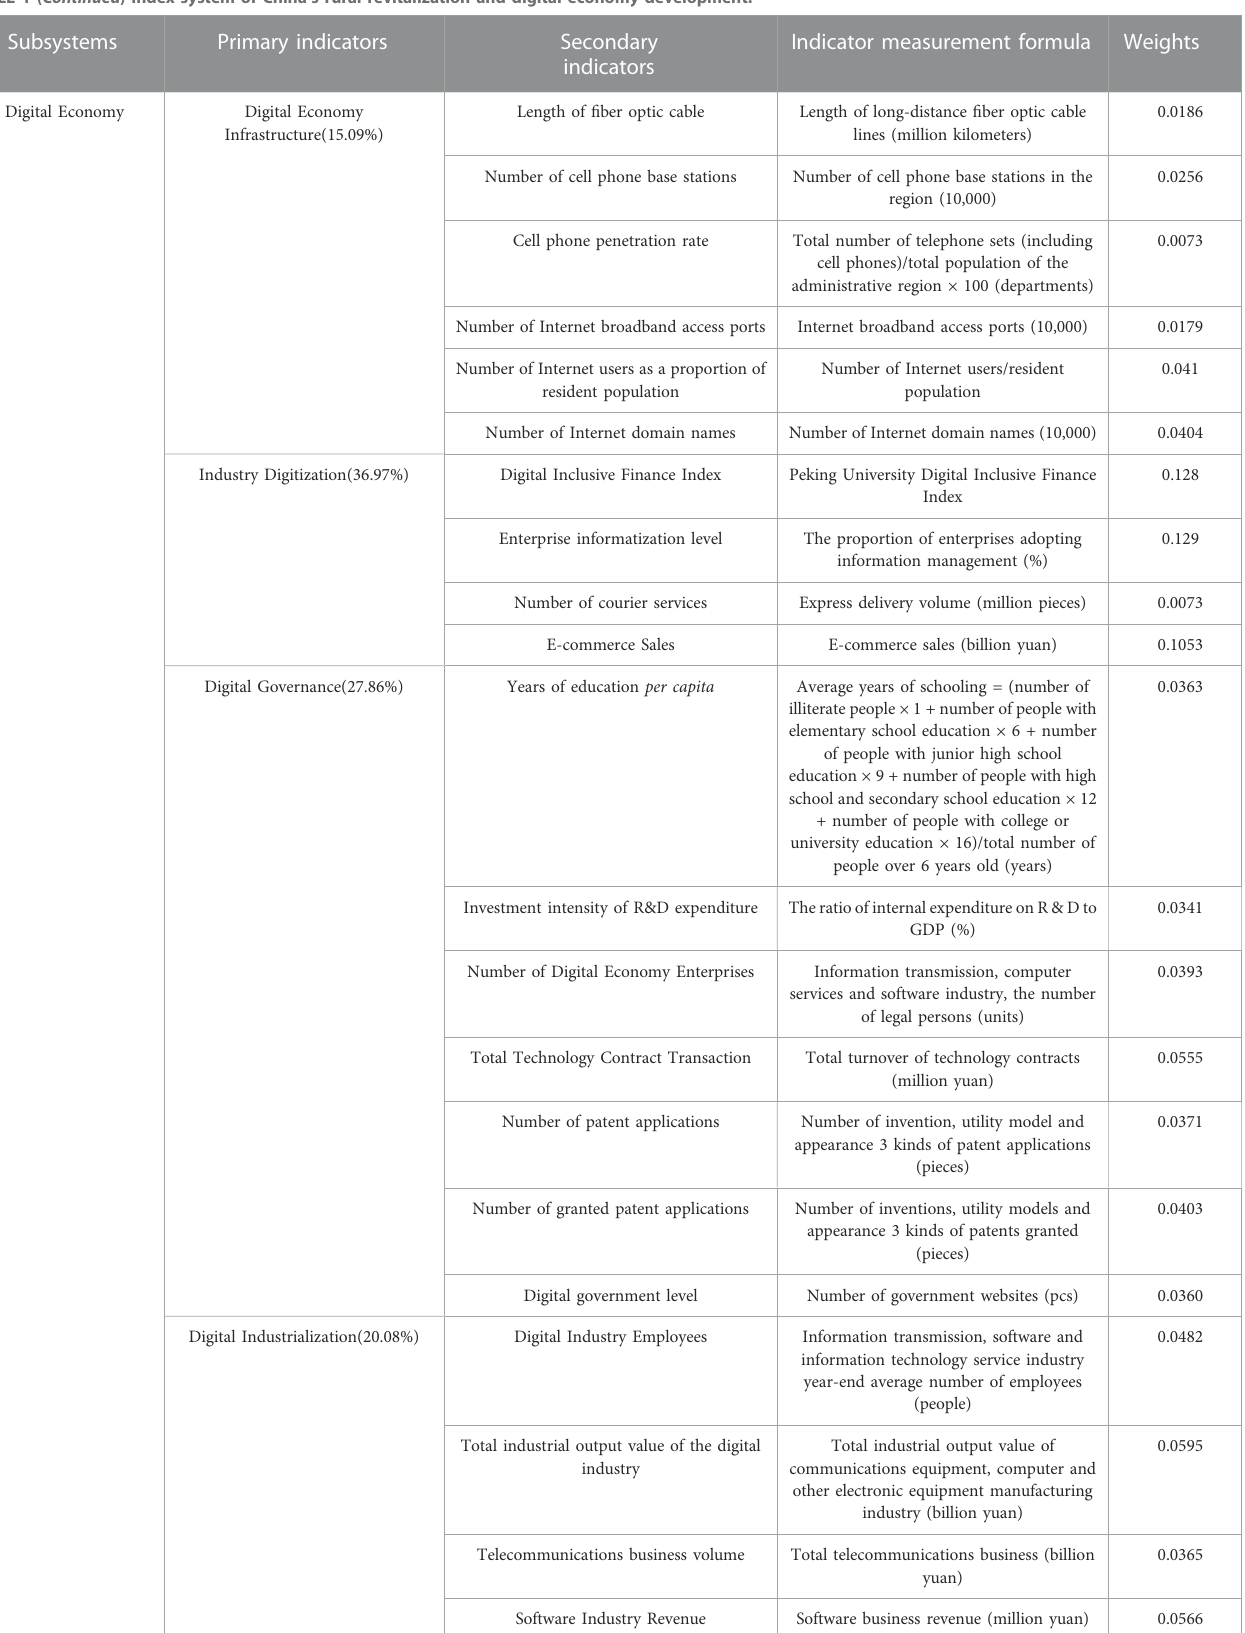
TABLE 1 ( Continued ) Index system of China ’ s rural revitalization and digital economy